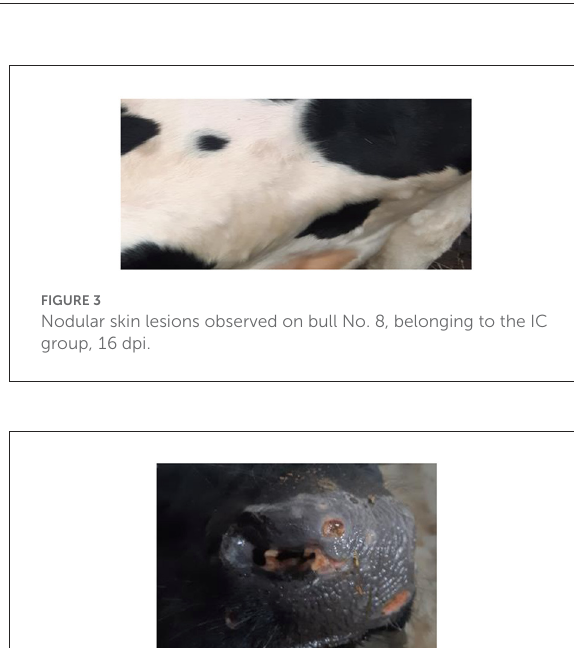
FIGURE4 Erosive skin lesions of the nasolabial speculum of bull No. 3, belonging to the IN group, 20 dpi.